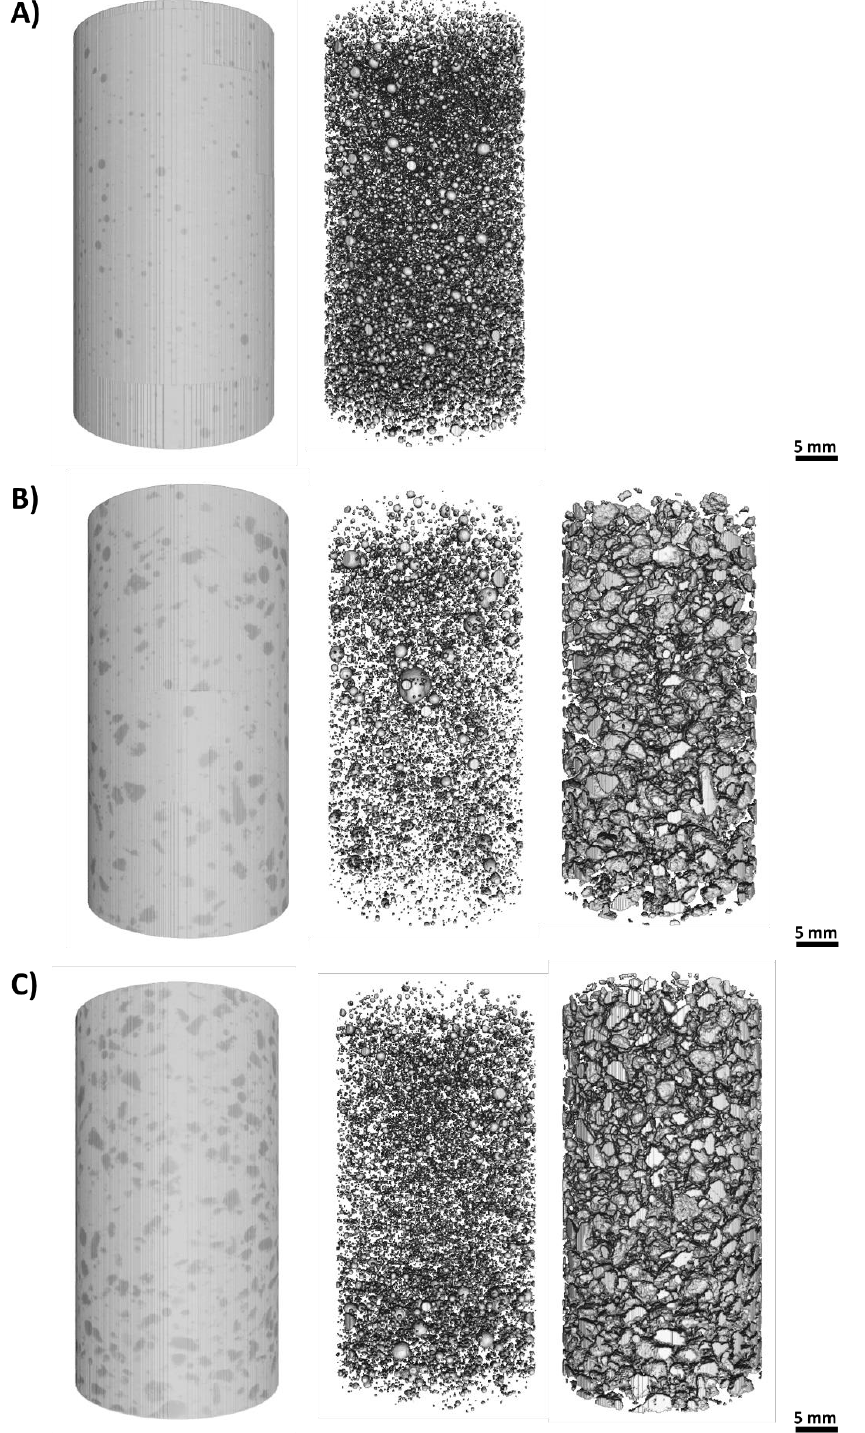
Figure 10. Illustration of binarization and segmentation process in ( A ) mixture 1 (0% EP), ( B ) mixture 4 (60% EP), and ( C ) mixture 6 (100% EP). The left-hand side of the panels show the volume rendering of the samples before binarization and segmentation; the middle images show the air voids; and the right-hand images show the EP aggregate.